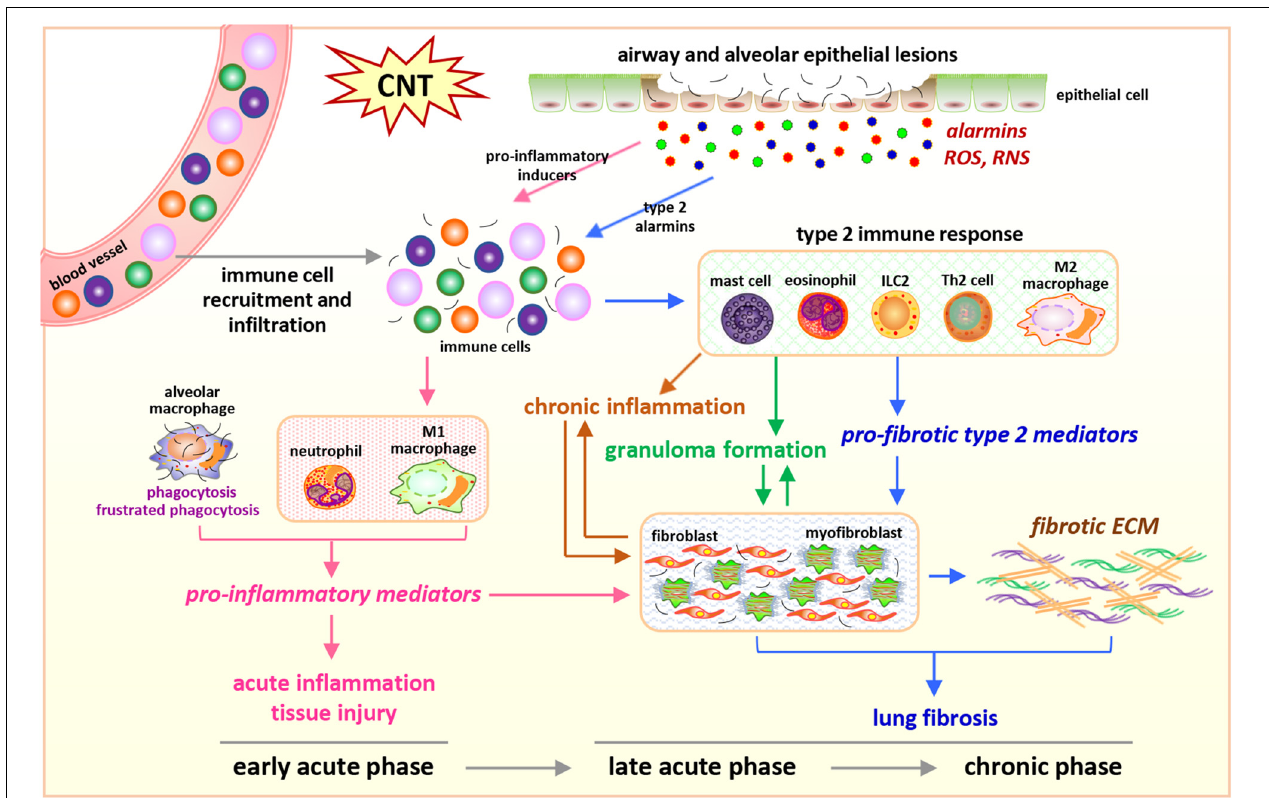
FIGURE 1 | Integrated perspective of microenvironmental mechanisms in CNT-exposed rodent lungs. Enriched numbers of neutrophils and M1 macrophages and elevated levels of pro-inflammatory factors are hallmarks of acute inflammation induced by CNTs during early acute phase response. In contrast, promoted by certain alarmins produced by injured epithelial cells, Th2-driven type 2 immune response and fibrotic response are predominant during late acute phase response and chronic phase response, marked by increased type 2 immune cells, type 2 mediators, fibroblastic cells, and ECM production and remodeling in the lung exposed